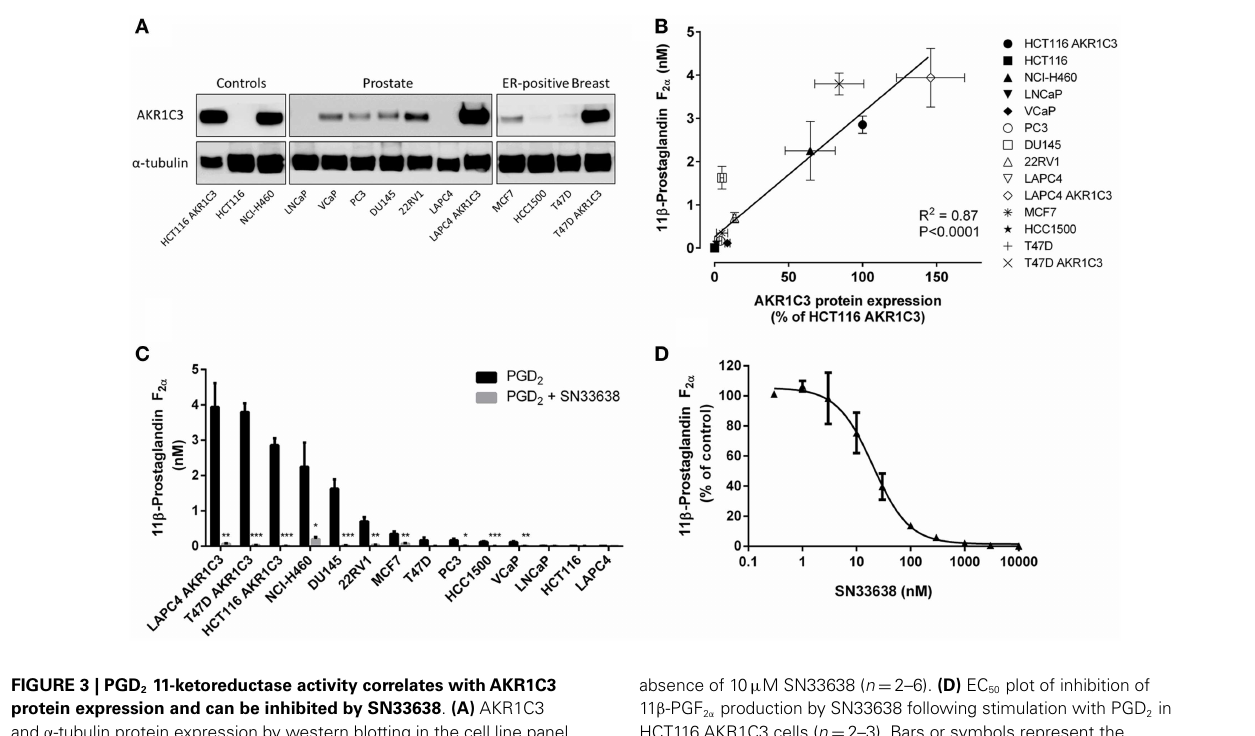
FIGURE 3 | PGD 2 11-ketoreductase activity correlates withAKR1C3 protein expression and can be inhibited by SN33638 . (A) AKR1C3 and α -tubulin protein expression by western blotting in the cell line panel. (B) Correlation between 11 β -PGF 2 α formation following stimulation with 28nM PGD 2 ( n = 2–6) and AKR1C3 protein expression (average of two to three independent lysates) in the cell line panel. (C) 11 β -PGF 2 α formation in the cell line panel after stimulation with PGD 2 in the presence or